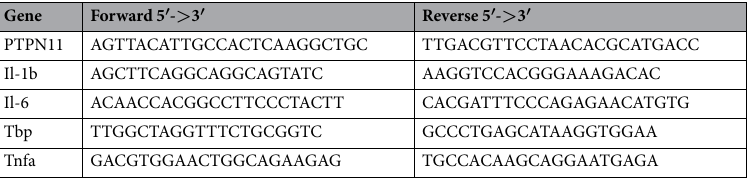
Table 1. List of primers used to determine mRNA of Shp2 and pro-inflammatory